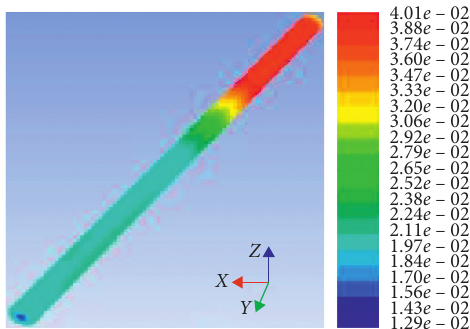
Figure 19: Speed vector cloud diagram of the threaded